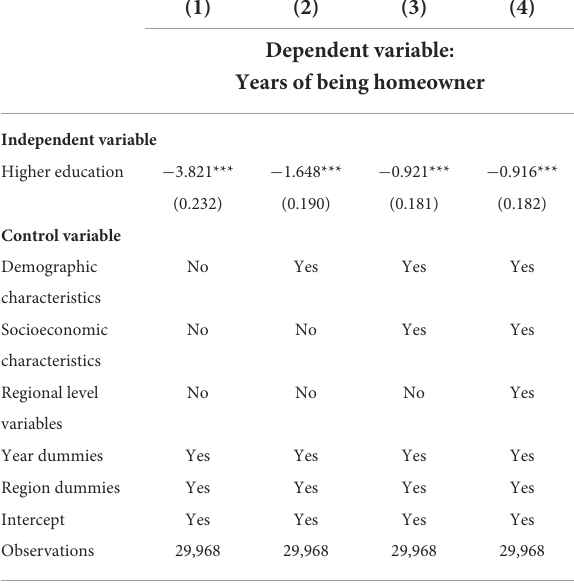
TABLE 7 Relationship between higher education and years of being